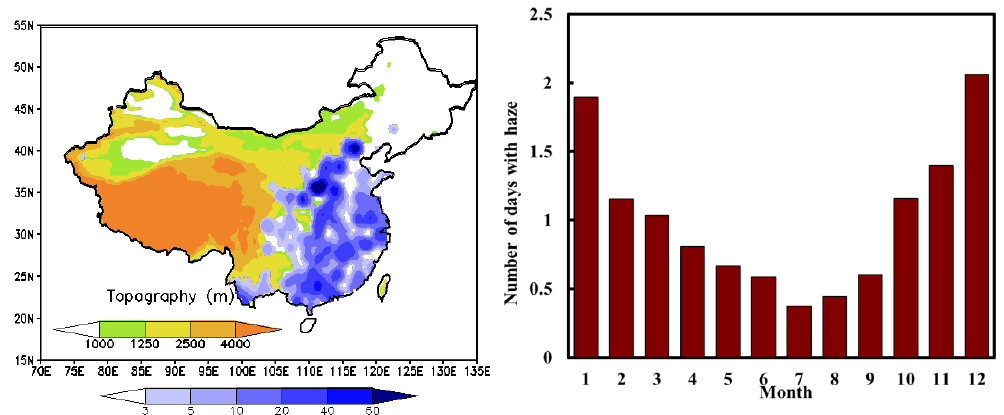
Figure 2. Distribution of annual haze event frequency (days per year) averaged over 1961–2012 in China, and Chinese topography of the TP and the Loess Plateau with altitudes is shown with yellow shades (left panel). Monthly variation of haze frequency averaged from 1961–2012 over the CEC region (right